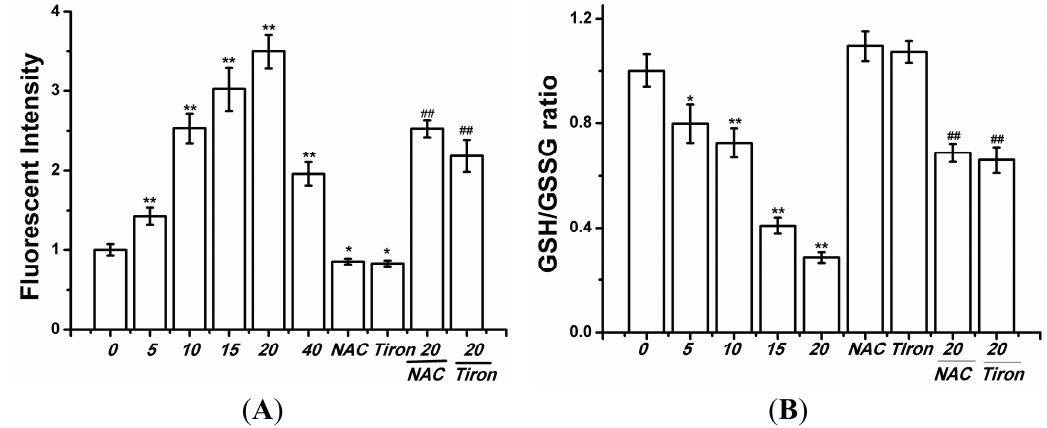
Figure 3. Effects of curcumin on redox state in BGC-823 cells. ( A ) The H 2 DCFDA probe was used to determine ROS level; ( B ) The GSH/GSSG ratio was used to measured oxidative stress. Control group (0 µM) level was represented as “1.0”. The value was expressed as means ± S.D. of three independent experiments. * p < 0.05, ** p < 0.01 compared with the control (0 µM) group; ## p < 0.05 compared with the curcumin-treated (20 µM)